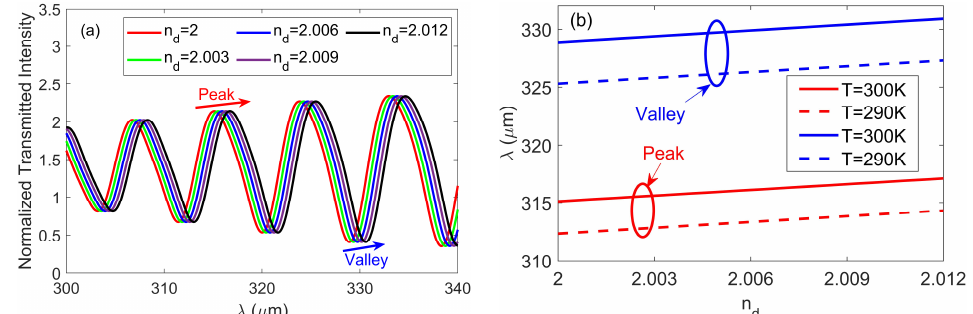
Figure 6. ( a ) Normalized transmitted intensity for proposed interferometers with different surrounding refractive index (RI; n d ) ranging from 2 to 2.012 at room temperature T = 300 K. ( b ) Peak (valley) wavelength versus refractive index n d with a different operating temperature T .